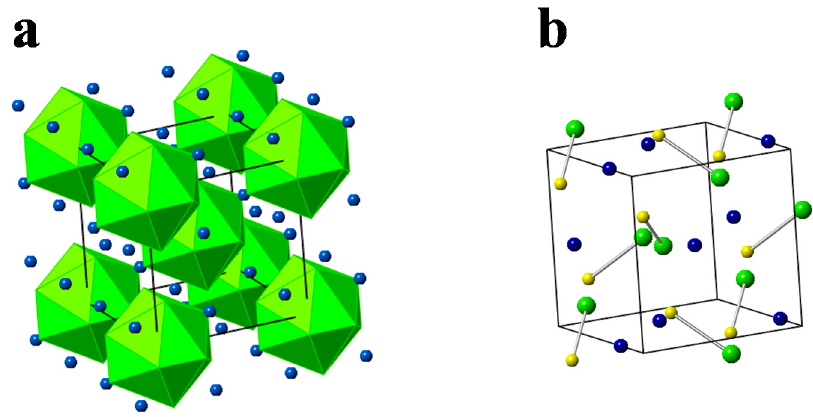
Figure 9. ( a ) Projection of the skutterudite structure showing icosahedral voids (green) defined by the positions of the arsenic atoms (not represented) and the cobalt atoms (blue); ( b ) Projection of the cobaltite structure showing the As–S pairs and the cobalt atoms (blue). Cobaltite and pyrite are isostructural only when the As–S pairs are fully disordered.